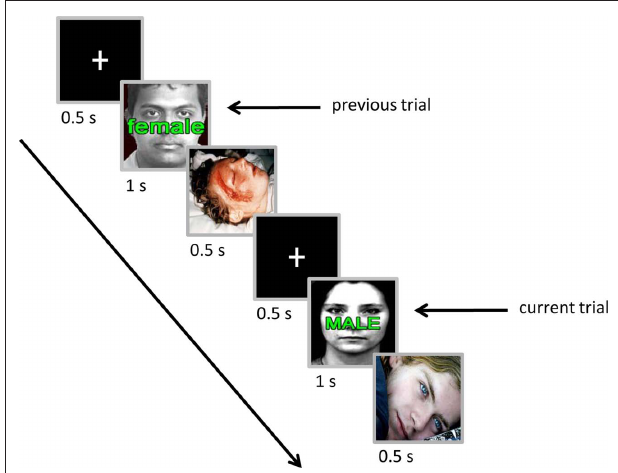
Figure 1 | experimental paradigm. Two consecutive trials are shown, illustrating an incongruent trial preceded by an incongruent trial with a negative emotional picture between them. The current-trial is followed by a neutral image. For simplicity, non-critical parts of the trials